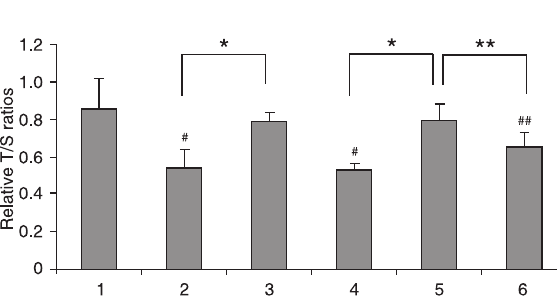
Figure 2. Quantitative PCR assay of relative telomere length in cardiomyocytes expressed as the relative T/S ratios. Columns : 1 , control group; 2 , castrated group; 3 , castrated + testoster- one group; 4 , sham-operated Tfm group; 5 , sham-operated